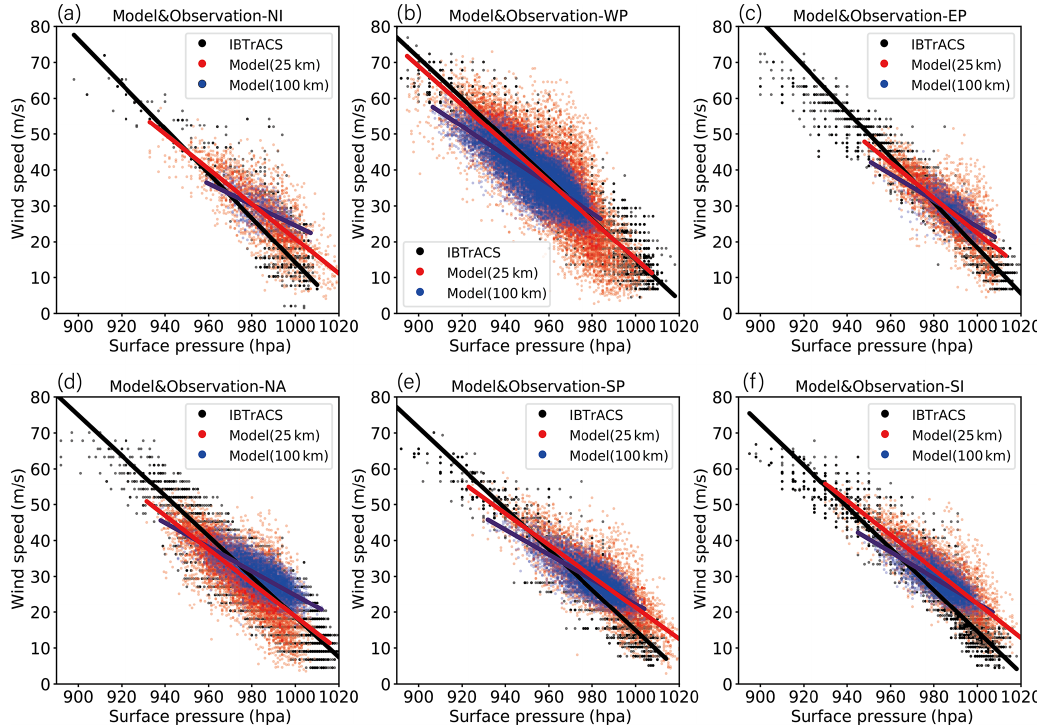
Figure 4. Pressure–wind pairs for each 6-hourly tropical cyclone measurement for FGOALS-f3-L (blue dots) and FGOALS-f3-H (red dots) and IBTrACS (black dots) in the (a) northern Indian Ocean, (b) western Pacific, (c) eastern Pacific, (d) northern Atlantic, (e) southern Pacific and (f) southern Indian oceans. A linear regression (blue/red line for FGOALS-f3-L/H; black line for IBTrACS) is fitted to each distribution of pressure–wind pairs.